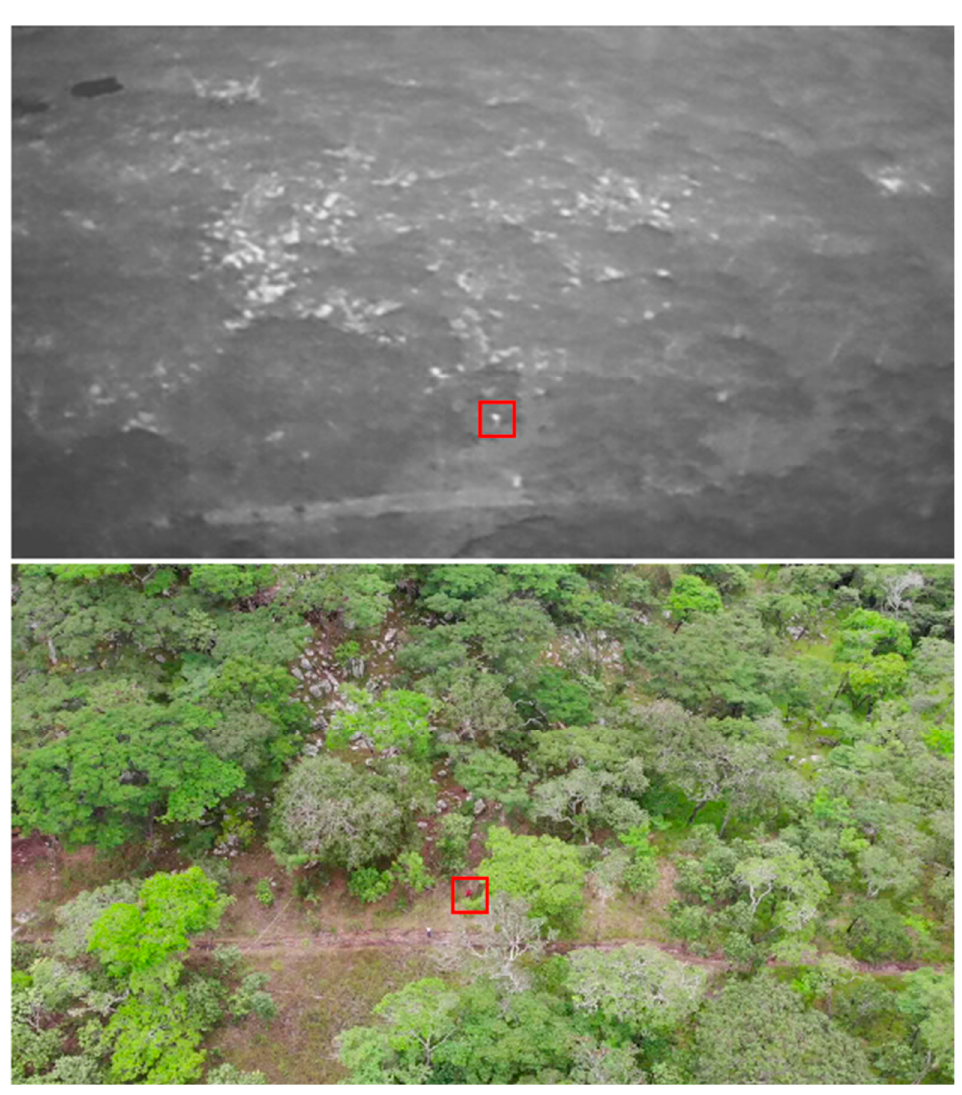
Figure A4. Comparison between thermal (top) and RGB images (bottom) at an oblique angle. Both images were taken in the same area and with the test subject in the same location. The red square indicates the location of the test subject.